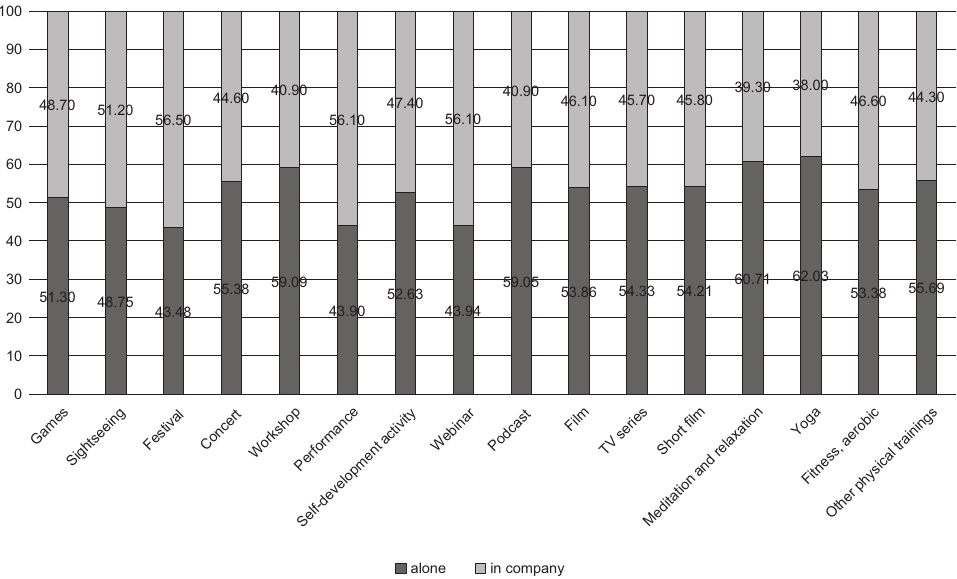
Fig. 1. Computer-based entertainment activities undertaken by the respondents with respect to the company of other people. Source: own elaboration based on online